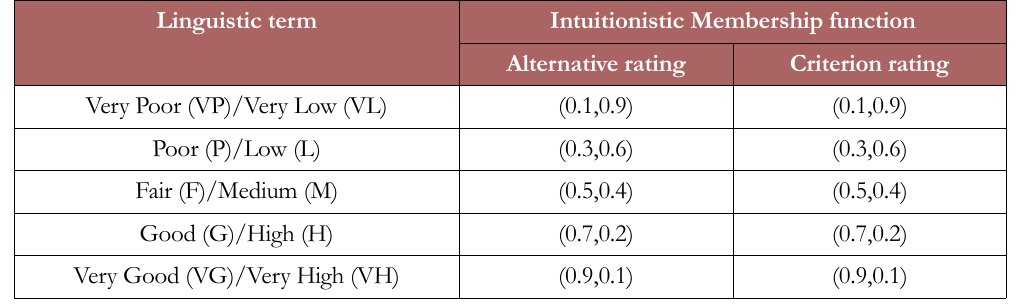
Table 15. Linguistic terms for alternatives and